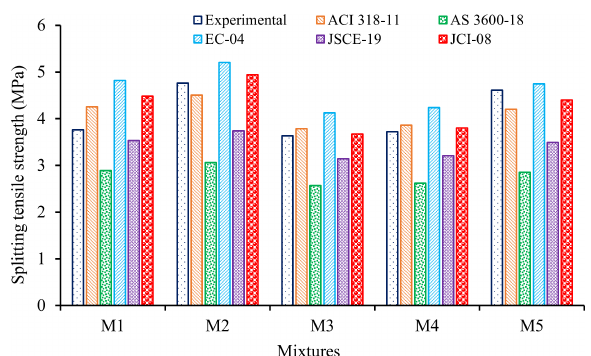
Fig. 6. Comparison in splitting tensile strength of concrete between experimental and calculated values.